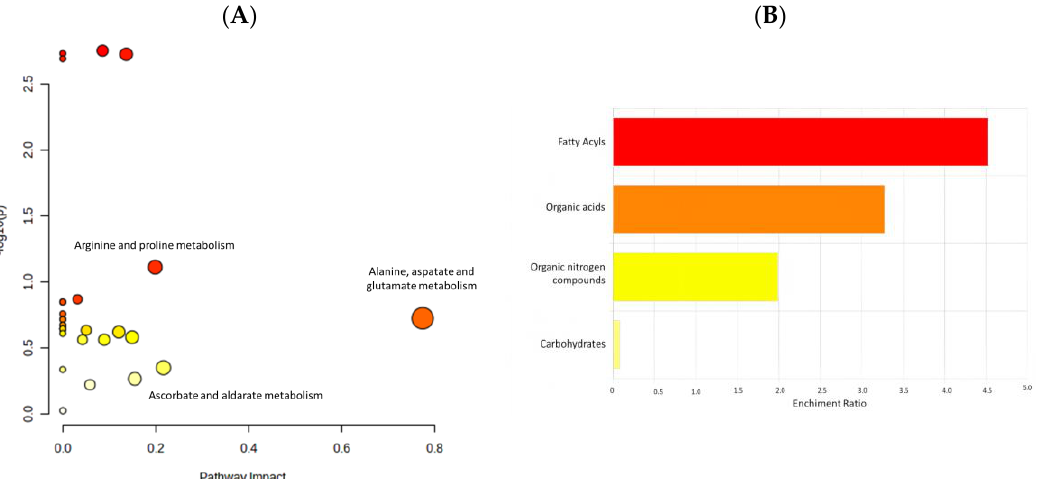
Figure 6. Pathway analysis. ( A ) Identification of the metabolic routes of the lemon peel altered by the variables studied (rootstock and culture medium). Pathways were considered significant when they presented a p -value < 0.05 and an impact factor > 0.2. ( B ) Bar graph resulting from the enrichment analysis of metabolites identified for the lemon peel samples.